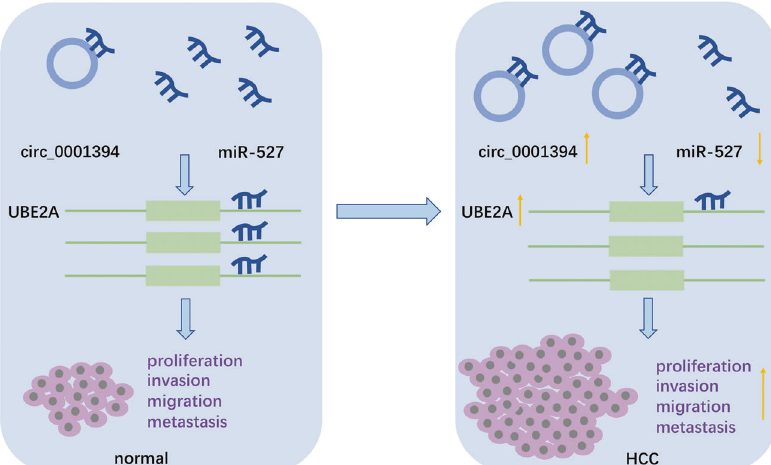
Fig. 8 The hsa_circ_0001394/miR-527/UBE2A axis promotes HCC proliferation, migration, and invasion. HCC hepatocellular